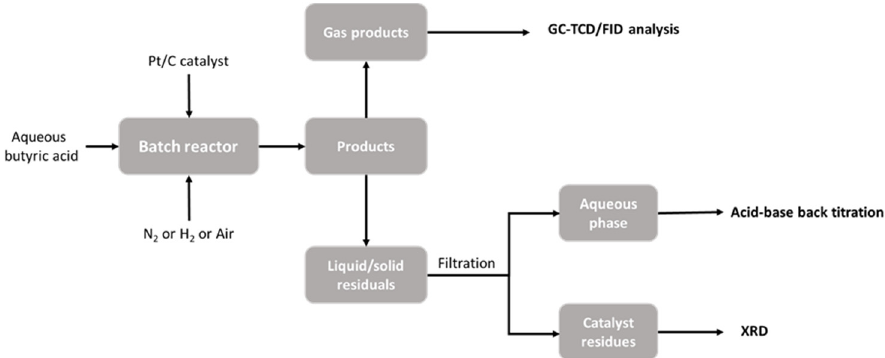
Figure 1. Schematic of experimental procedure used in this work.